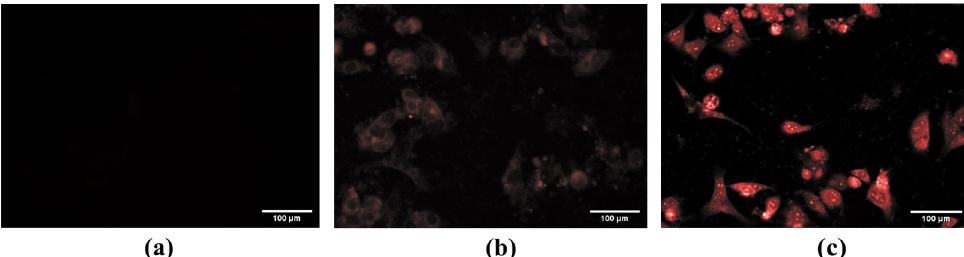
Figure 4. Fluorescent microscopy images of MCF-7 breast cancer cells after 3 h of incubation without nanoparticles (negative control) ( a ) and with YVO 4 :Eu 3+ @silica-NH 2 nanoparticles at a concentration of 20 µ g/mL ( b ) and YVO 4 :Eu 3+ @silica-NH-GDA-IgG conjugates at a concentration of 20 µ g/mL ( c ) under an excitation wavelength in the UV region.